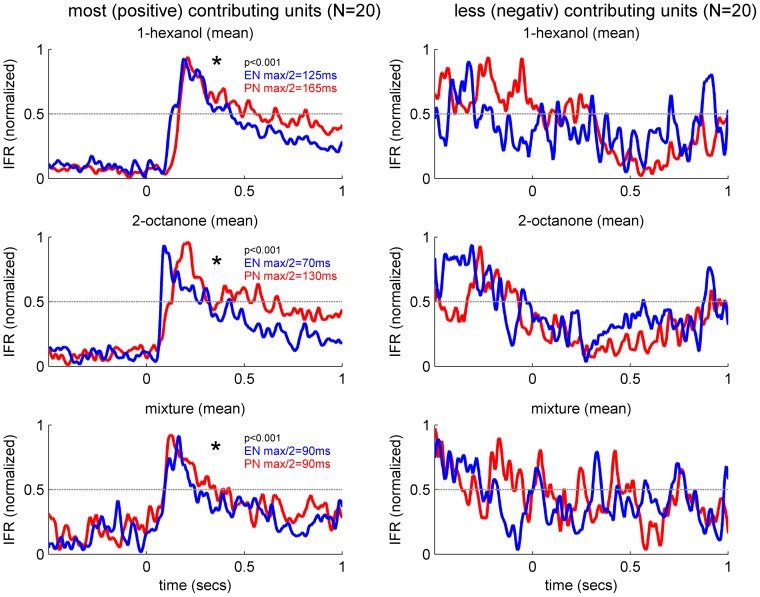
Rapid excitatory activity in response contributing ENs.Normalized mean instantaneous firing rate (IFR) for the different odor stimuli. (Left) IFR of the first 20 PN-units (red, cp. Figure 3A) and the first 20 EN-units (blue, cp. Figure 4A) showing the most positive contributions to the related odor representation. For the pure odors 1-hexanol and 2-octanone the mean EN responses reached the half maximal response rate 40–60 ms before the PN-units. Before normalization the mean rates of PN-units and EN-units were tested using a Kolmogorov Smirnov test (p<0.001). Mean rates in PNs and ENs were significantly different for all stimuli. (Right) IFR of the last 20 PN-units (red, cp. Figure 3A) and the last 20 EN-units (blue, cp. Figure 4A) showing the most negative contributing units. Note, there was no odor related activity in units contributing negatively to the odor representation.